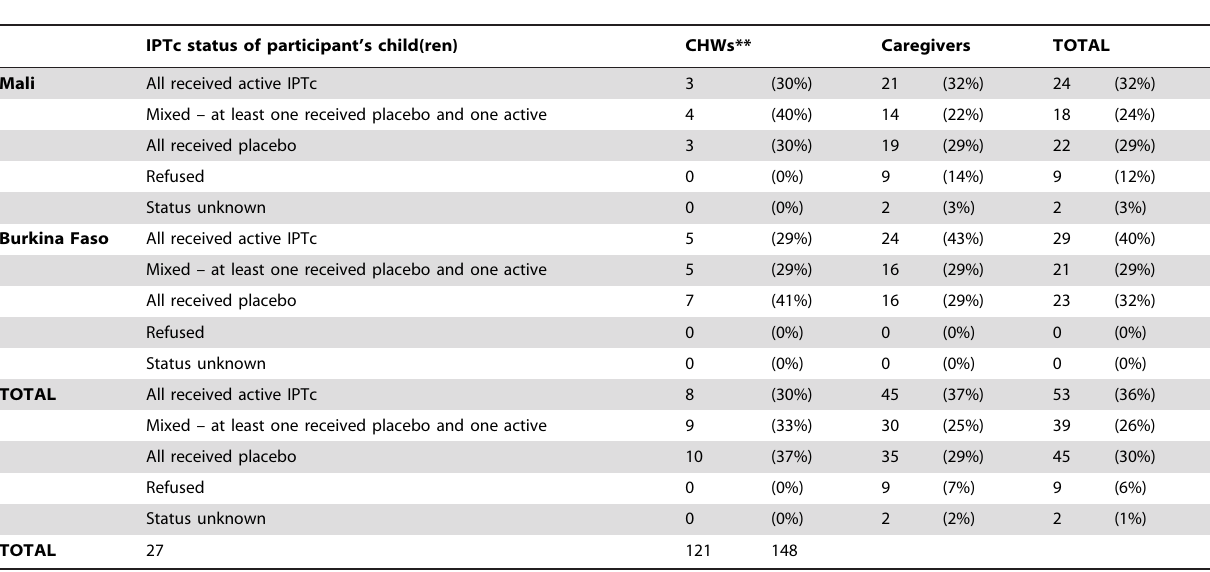
Table 2. Trial status of the children of participating caregivers.